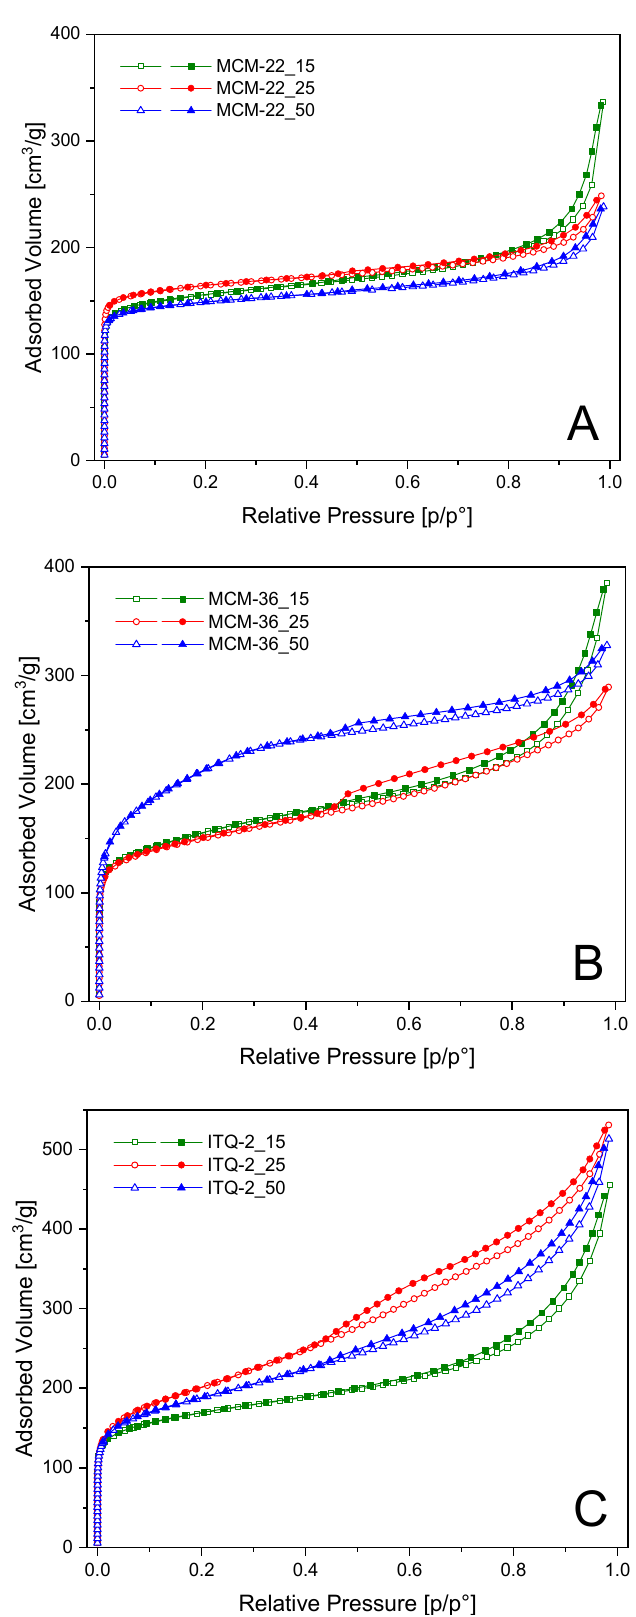
Figure 3. Dinitrogen adsorption–desorption isotherms of MCM-22 ( A ), MCM-36 ( B ), and ITQ-2 ( C )